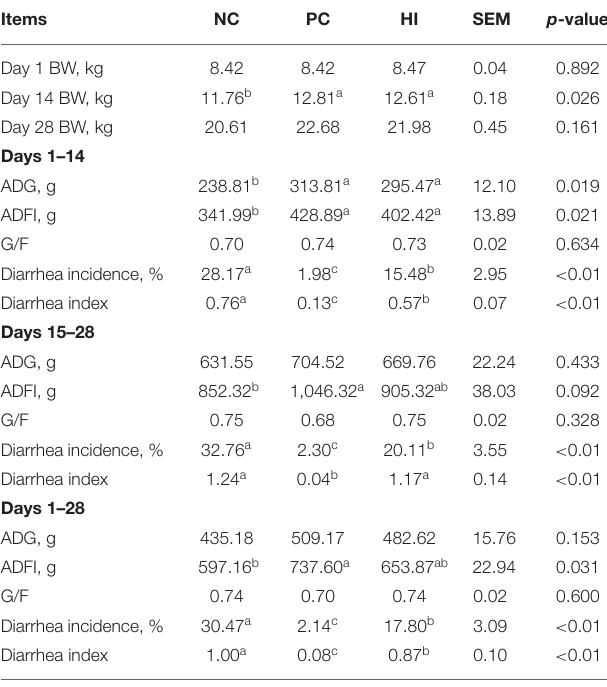
TABLE 4 | Effects of dietary Hermetia illucens larvae meal on growth performance and diarrhea incidence in weaned pigs.